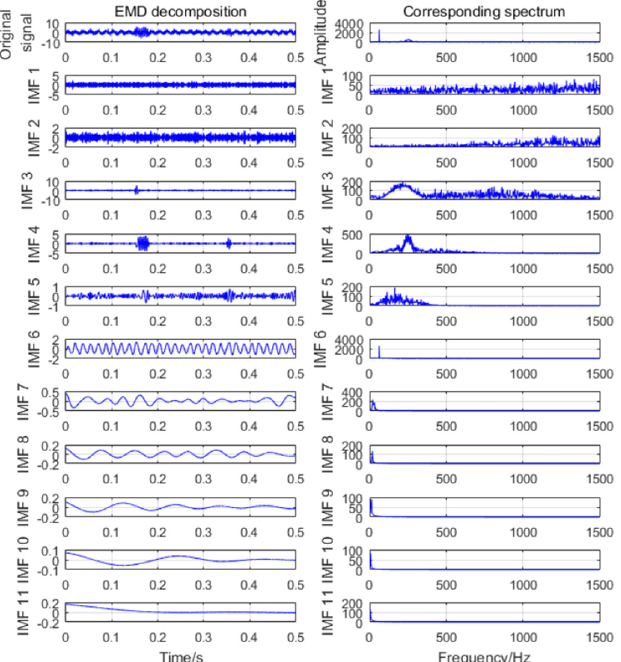
Fig. 3. EMD signal decomposition time domain and frequency domain